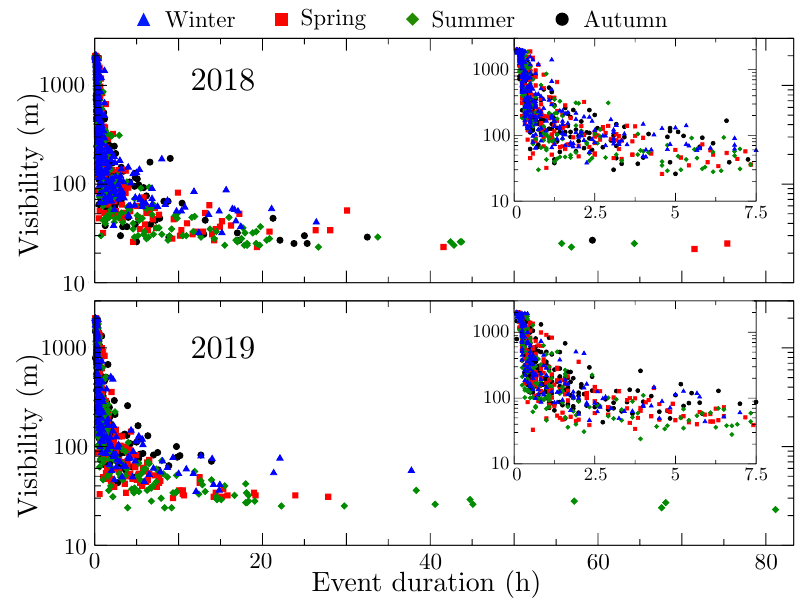
Figure 4. Representation of minimum visibility vs. event duration for 2018 and 2019, and for the 2000 m threshold. Low visibility events from the different seasons are distinguished by different markers and colors. For each year, the inset in the upper right corner represents a zoom in the horizontal